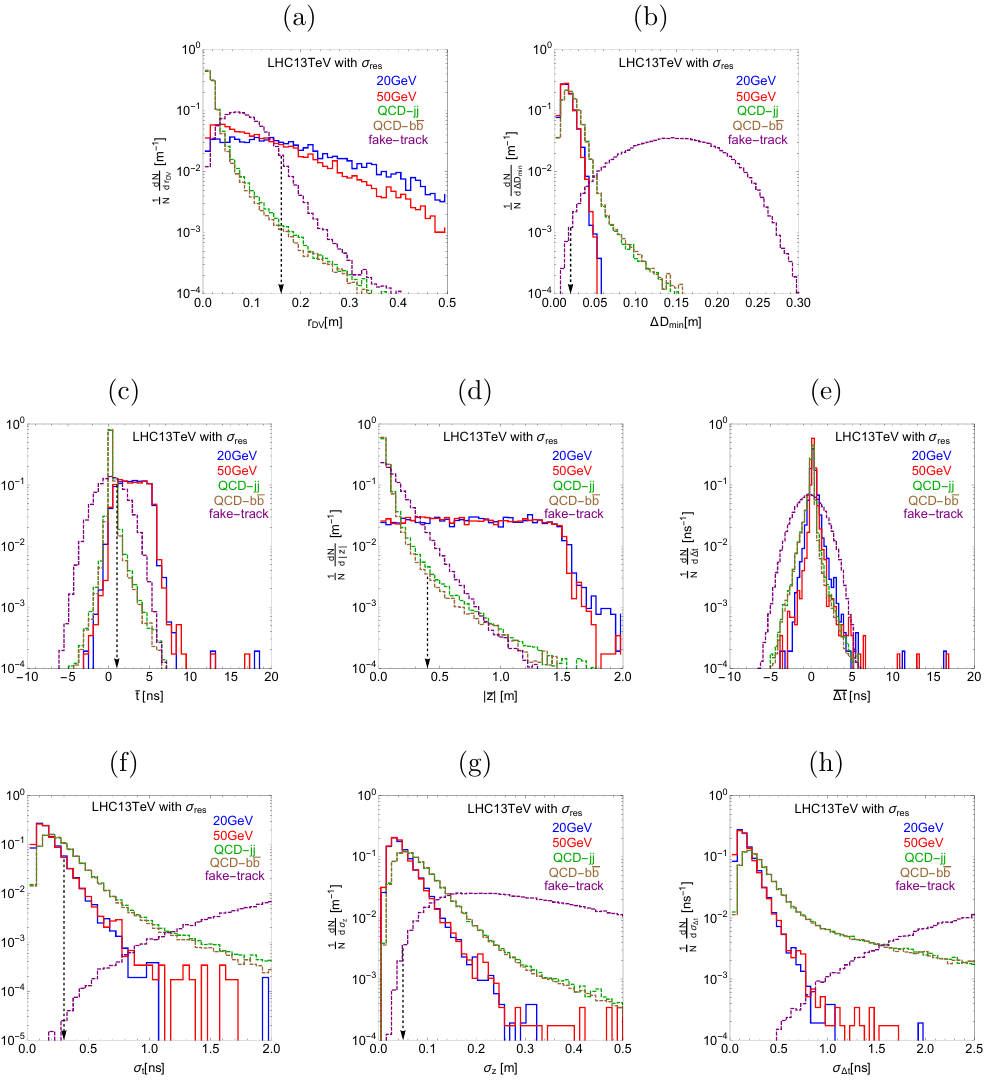
Figure 5 . The kinetic distributions of the leading five tracks for the QCD background, fake-track background and the gluon fusion signal with the angular resolution effect applied. The variables are r DV , ∆D min in the top row, ¯t , | ¯z | , ∆t in the middle, and σ t , σ z , σ ∆t in the bottom row. For the signal, we take m X to be 20 and 50 GeV respectively, with the same lifetime of cτ X = 1 m. The vertical dotted black line indicates the cut proposed on the